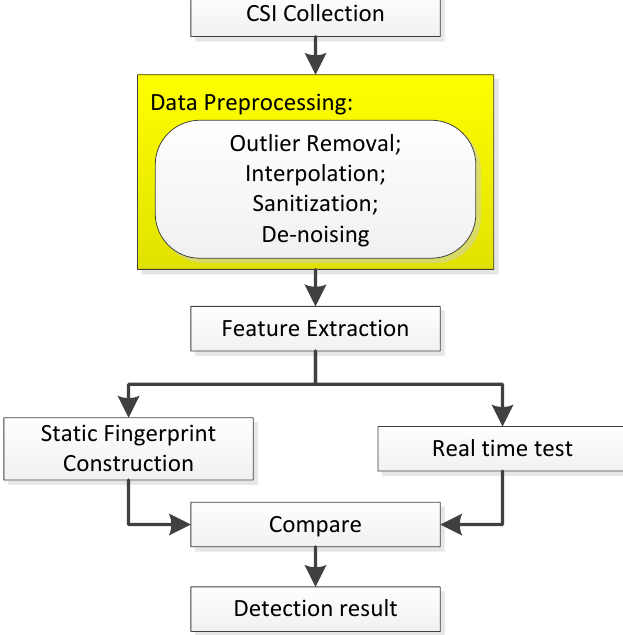
Figure 1. Common architecture of former